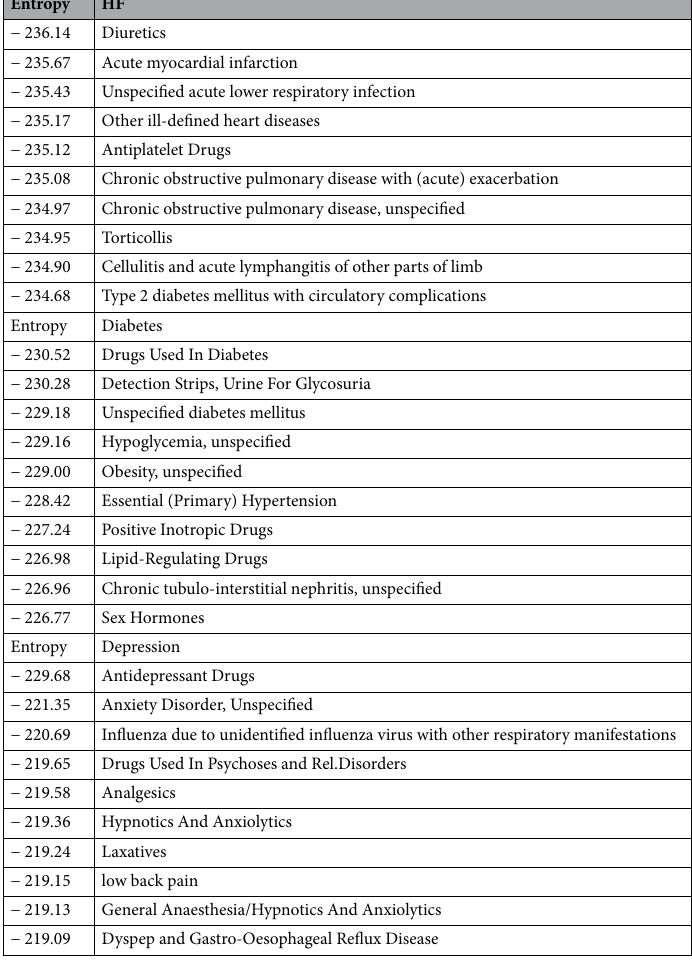
Table 3. Top 10 lowest entropy diagnoses/medications for heart failure, diabetes, and